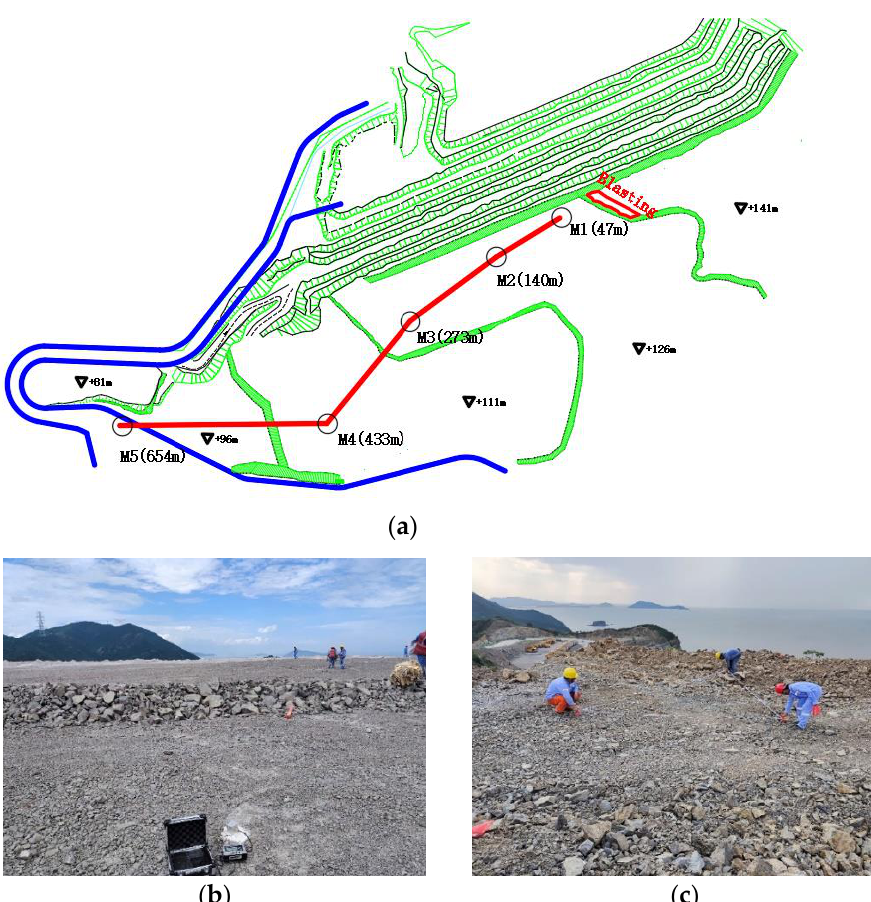
Figure 2. Blasting Vibration Monitoring: ( a ) Measuring point layout (141 Blasting area); ( b ) Monitoring instrument at the measuring point; ( c ) The site of the blasthole layout.